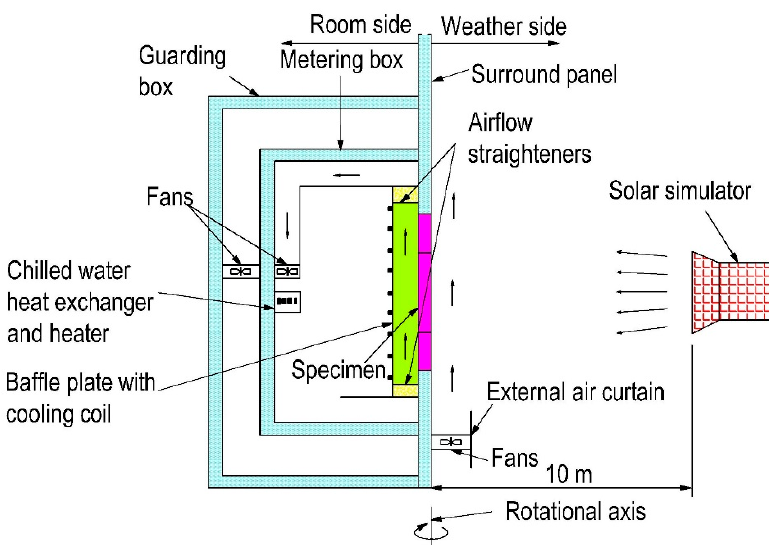
Figure 7. Layout of the test [32].